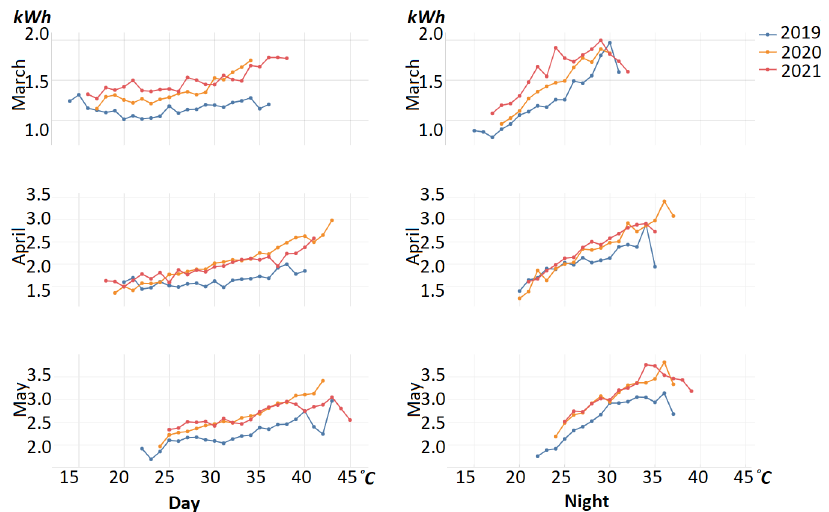
Figure 10. Consumption vs. temperature comparison for 3 analogous months (March, April, and May) over 3 years.